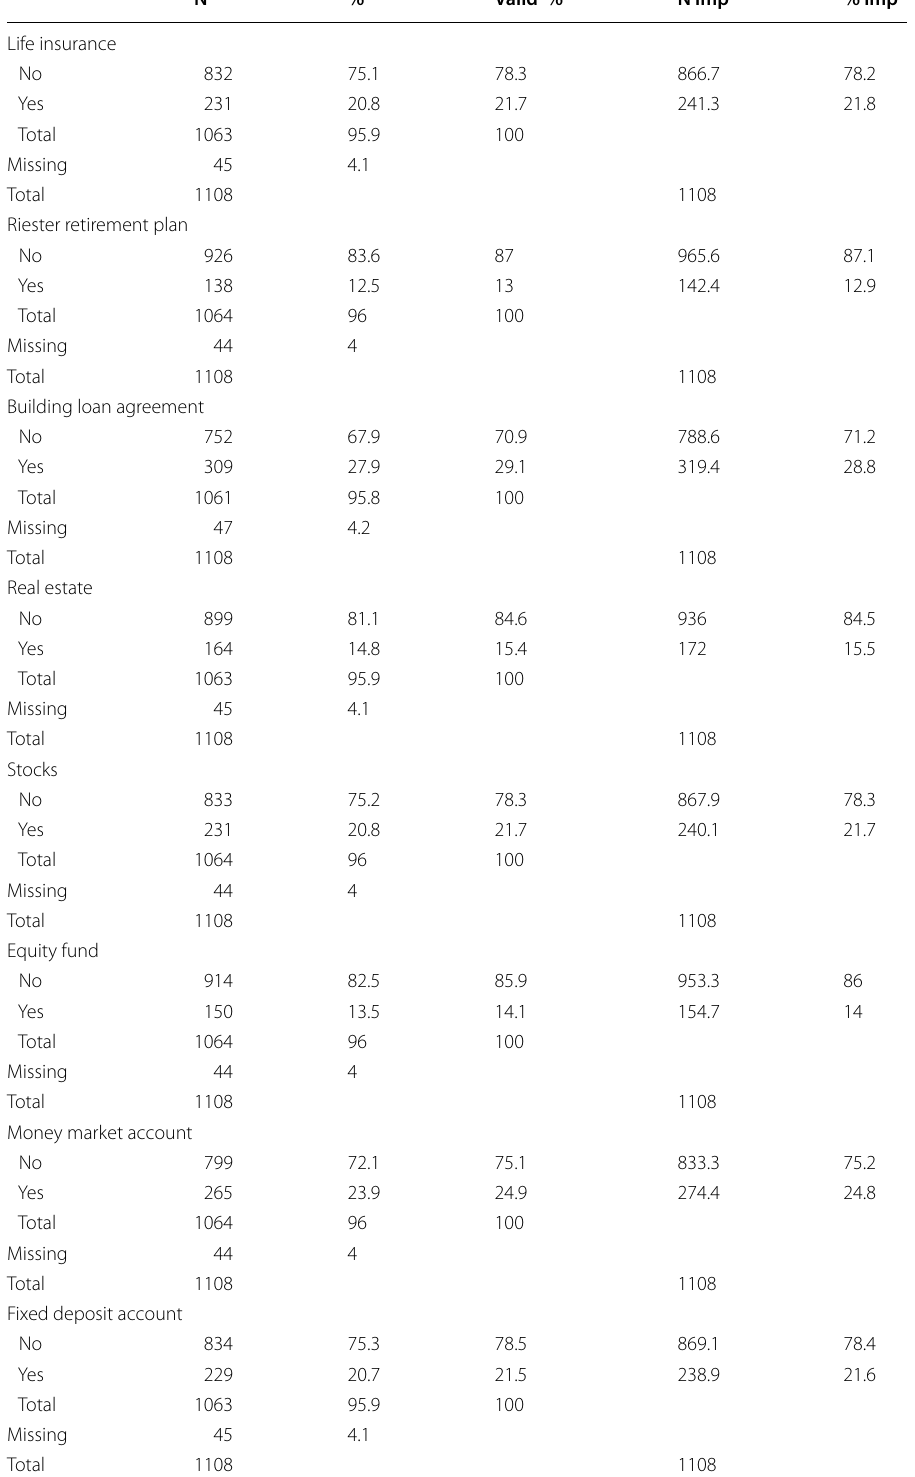
Table 1 Information behavior towards common financial